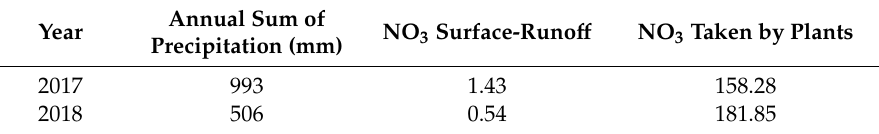
Figure 6. Daily outflow of nitrogen from the Gizdepka Stream, 2017–2018. There is also a correlation between the amount of precipitation, the quantity of nitrates in surface runoff, and the quantity of nitrates taken by plants (Table 4). The lower the precipitation, the less compounds are washed away, and thus the plants have more time to take them from the soil. Table 4. Annual sum of nitrogen taken by the plants and leached into Puck Bay.